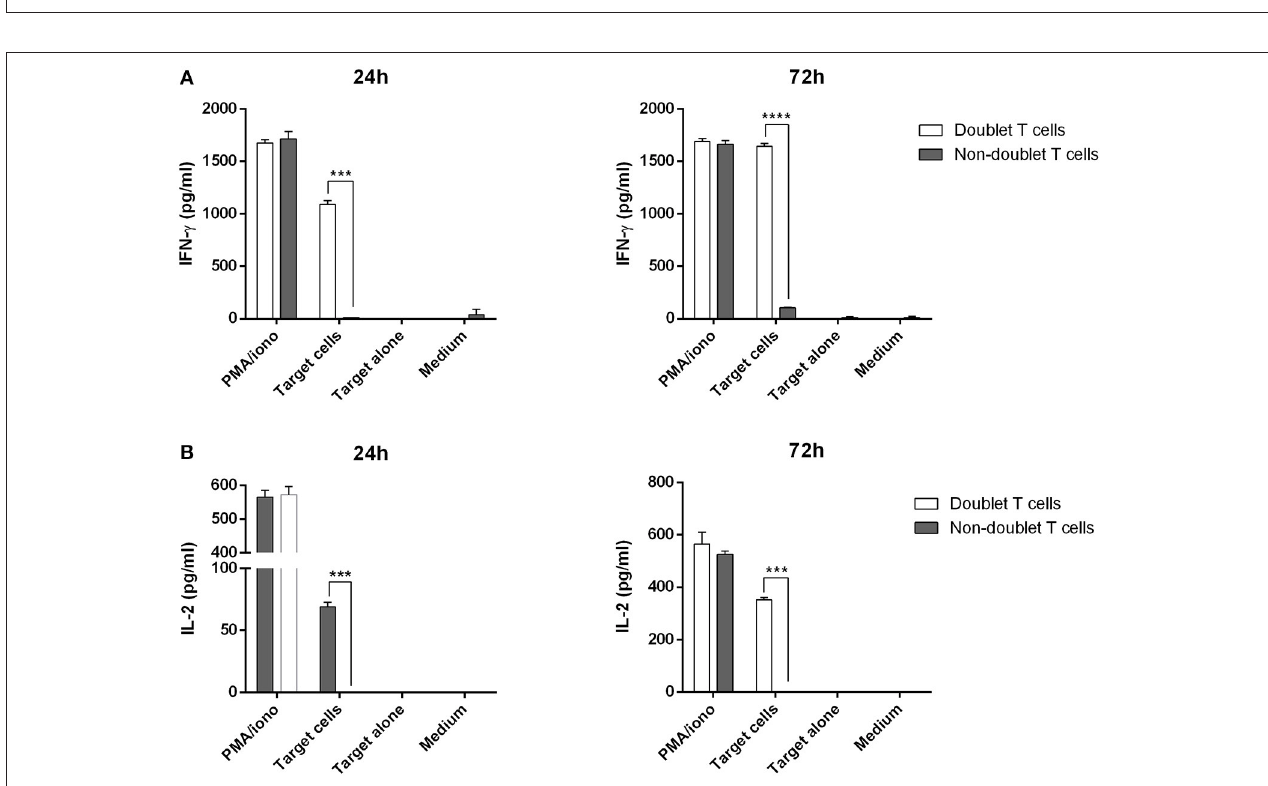
FIGURE 3 | an example of analyses performed. (C) The bar diagram shows the specific lysis of doublet-forming T cells vs. non-doublet T cells. The specific lysis was calculated following the next formula: [(target viability alone–target viability with doublet or non-doublet T cells)/ target viability alone] × 100. Data show mean values ± SD of six independent experiments. (D) The bar diagram shows the expression of CD107a cytotoxic marker of doublet-forming T cells vs. non-doublet T cells. Data show mean values ± SD of three independent experiments. (E) The bar diagram shows the percentage of T cell activation marker CD69 on secondary co-cultures after 24h of incubation as determined by flow cytometry. Data show mean values ± SD of three independent experiments. P -values between the indicated groups were calculated using paired Student t -tests. ** p < 0.01.